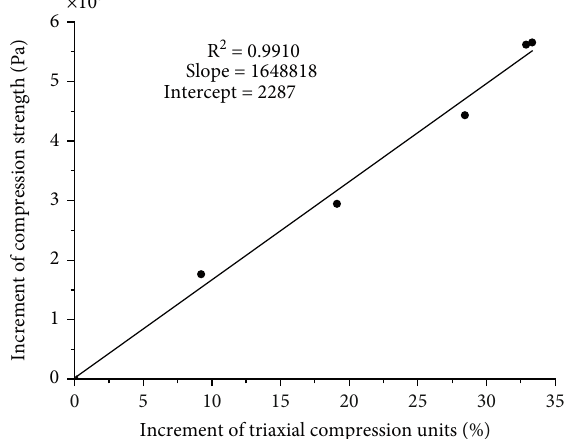
Figure 14: The Mohr strength curve and the Mohr